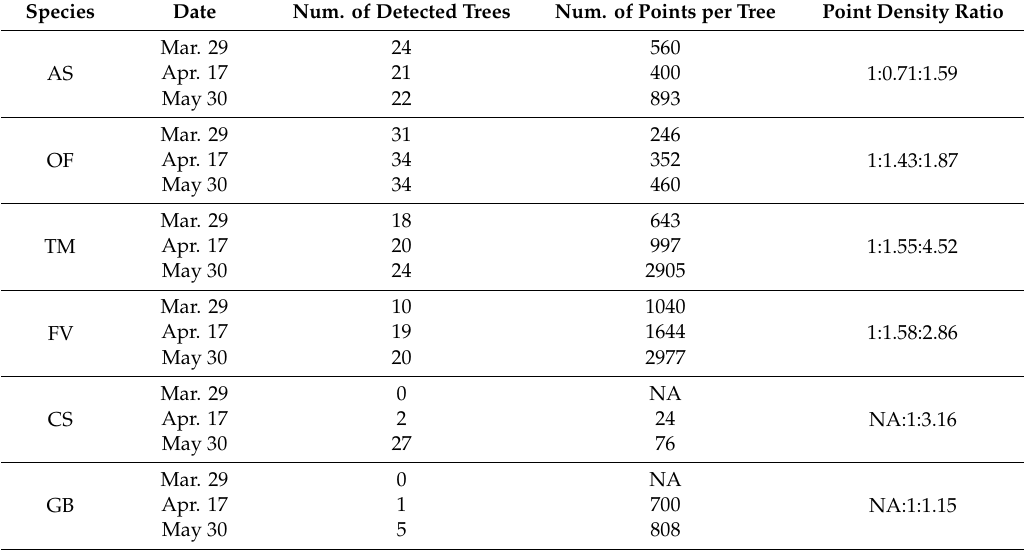
Table 5. Point density of trees detected from the photogrammetric point cloud on three dates. From the algorithm, the number of detected trees and their corresponding point clouds can be determined; thus, the average number of points per tree for the given period was calculated. The last column shows how the point density per tree changes with time. (NA: not